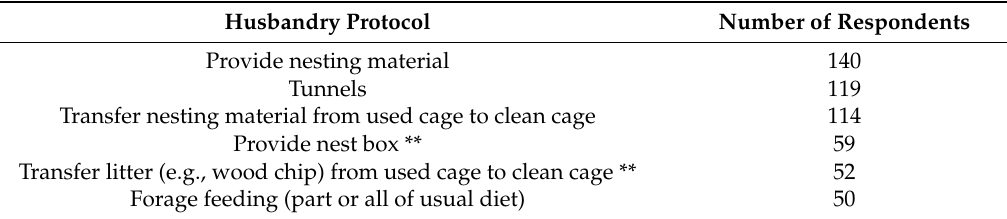
Table 4. Husbandry practices used for group housed male mice in a range of establishments. Husbandry Protocol Number of Respondents Provide nesting material 140 Tunnels 119 Transfer nesting material from used cage to clean cage 114